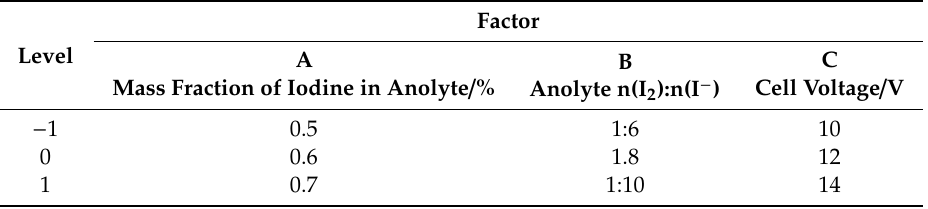
Table 1. Analytical factors and levels of the response surface methodology.